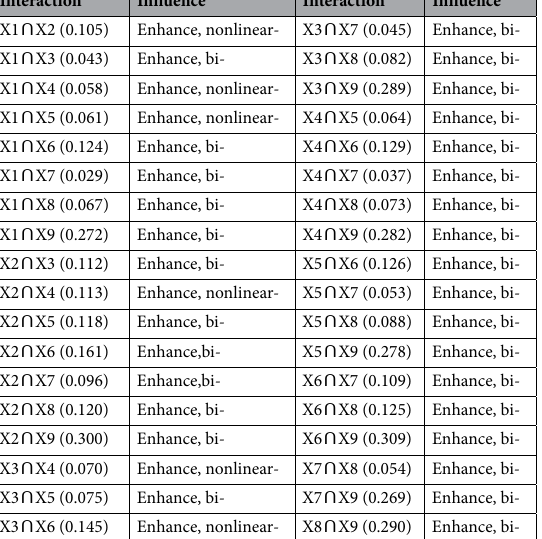
Interaction Influence